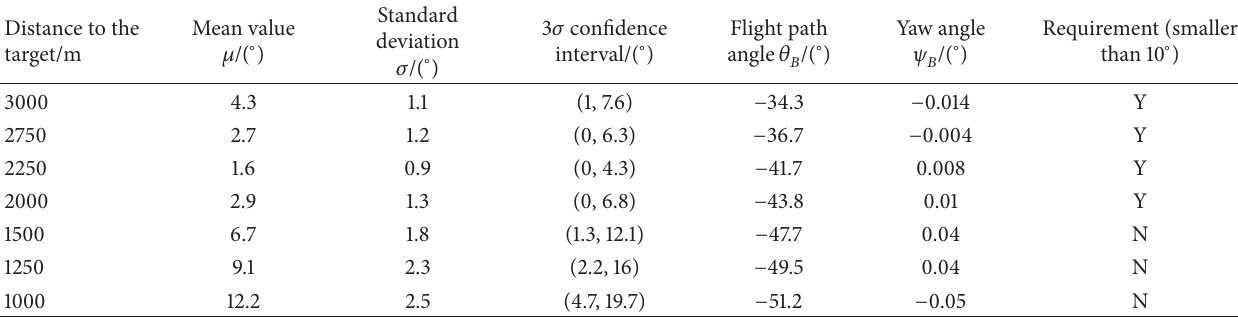
Table 4: View angle distribution results (moving